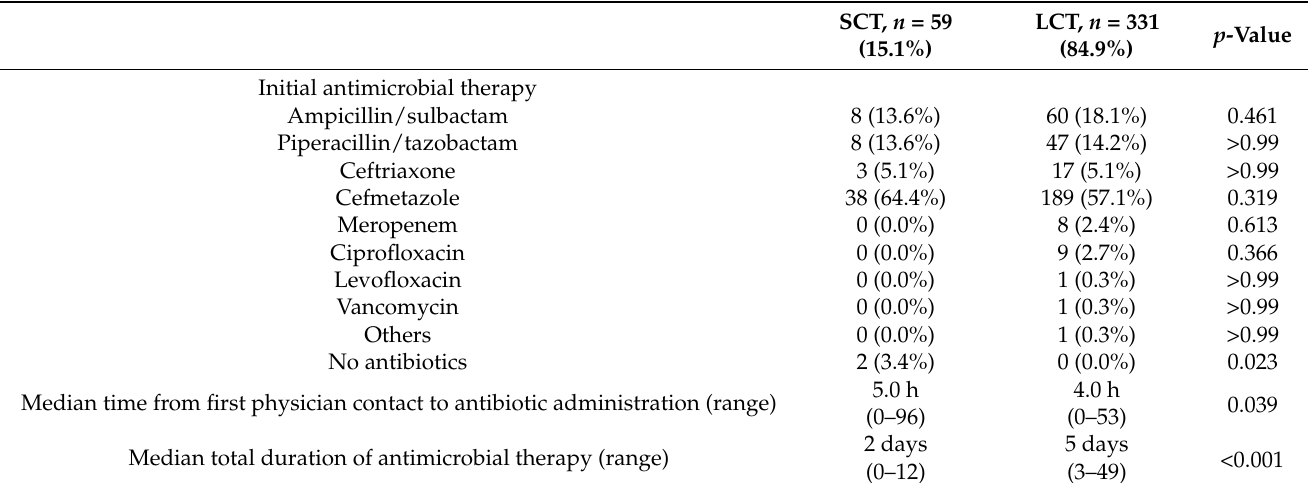
Table 4. Antibiotic